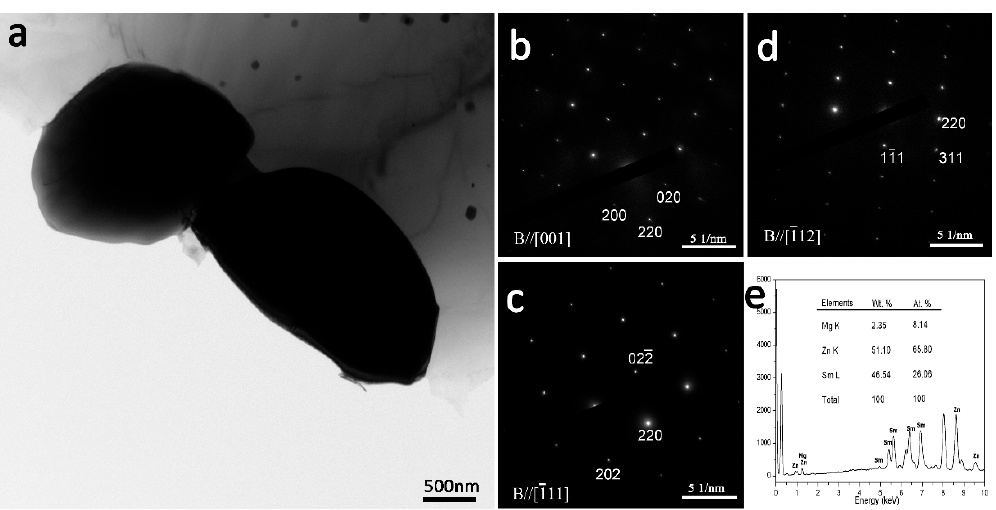
Figure 10. The bright field TEM micrograph of the micron-sized phase observed in as-extruded Mg–4Sm–2Zn–0.5Zr alloy for ( a ) and the corresponding SAED patterns taken along the [001] direction for ( b ), the [1(cid:3364)11] direction for ( c ) and the [1(cid:3364)12] direction for ( d ), respectively. ( e ) The EDS pattern of the micron-sized phase in Figure 10a.